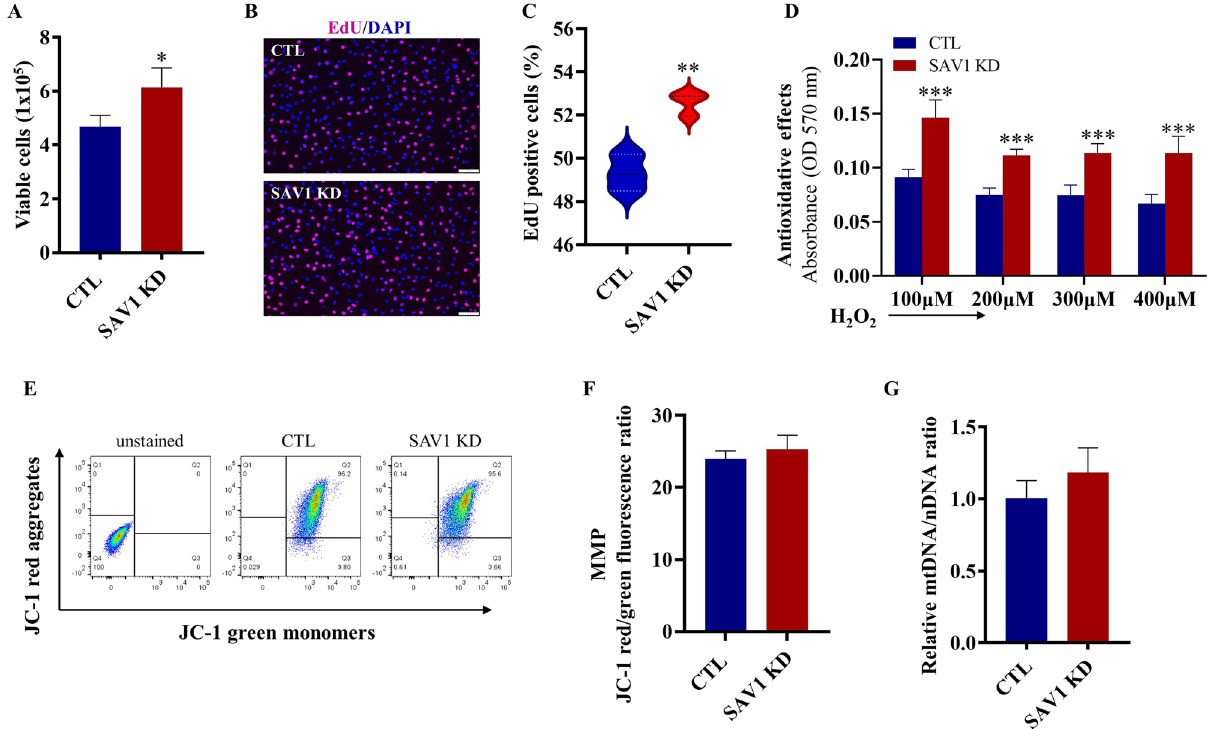
Figure 3. SAV1 KD in C2C12 myoblasts increased cell proliferation and survival. ( A ) Summary of viable cell counts with trypan blue exclusion in SAV1 KD cells and CTL cells at 48 h after SAV1 siRNA or negative control siRNA transfection. Data are mean ± SD; n = 4 independent counts. Unpaired t test; *p < 0.05. ( B ) Representative images of EdU-labeled nuclei in CTL and SAV1 KD cells at 72 h post-siRNA transfection. Cells were treated with EdU for 2 h before fixation. ( C ) SAV1 KD cells exhibited a higher percentage of EdU incorporation (EdU + nuclei) than did CTL cells. Unpaired t test; data are mean ± SD; n = 3 independent assays. **p < 0.01. ( D ) MTT cell viability assay showed the significantly increased survival capability of SAV1 KD cells as compared to CTL cells after being exposed to 100–400 μM H 2 O 2 for 2 h. Unpaired t test; data are mean ± SD, n = 3 independent assays. ***p < 0.001. ( E ) Flow cytometry analysis of mitochondrial membrane potential of CTL and SAV1 KD cells by JC-1 staining. ( F ) The ratio of cell percentage of JC-1 red fluorescent aggregates (percentage of cells in Q2) to cell percentage of JC-1 green fluorescent monomers (percentage of cells in Q3) is similar in CTL and SAV1 KD groups. Data are mean ± SD; n = 4 independent assays. ( G ) Analysis of mitochondrial DNA (mtDNA) content in SAV1 KD and CTL cells by quantitative PCR. Nd1 (Mitochondrially Encoded NADH:Ubiquinone Oxidoreductase Core Subunit 1) and Hk (Hexokinase-2) genes were amplified and used to quantify the mtDNA/ nDNA ratio. Data are mean ± SD; n = 3 independent